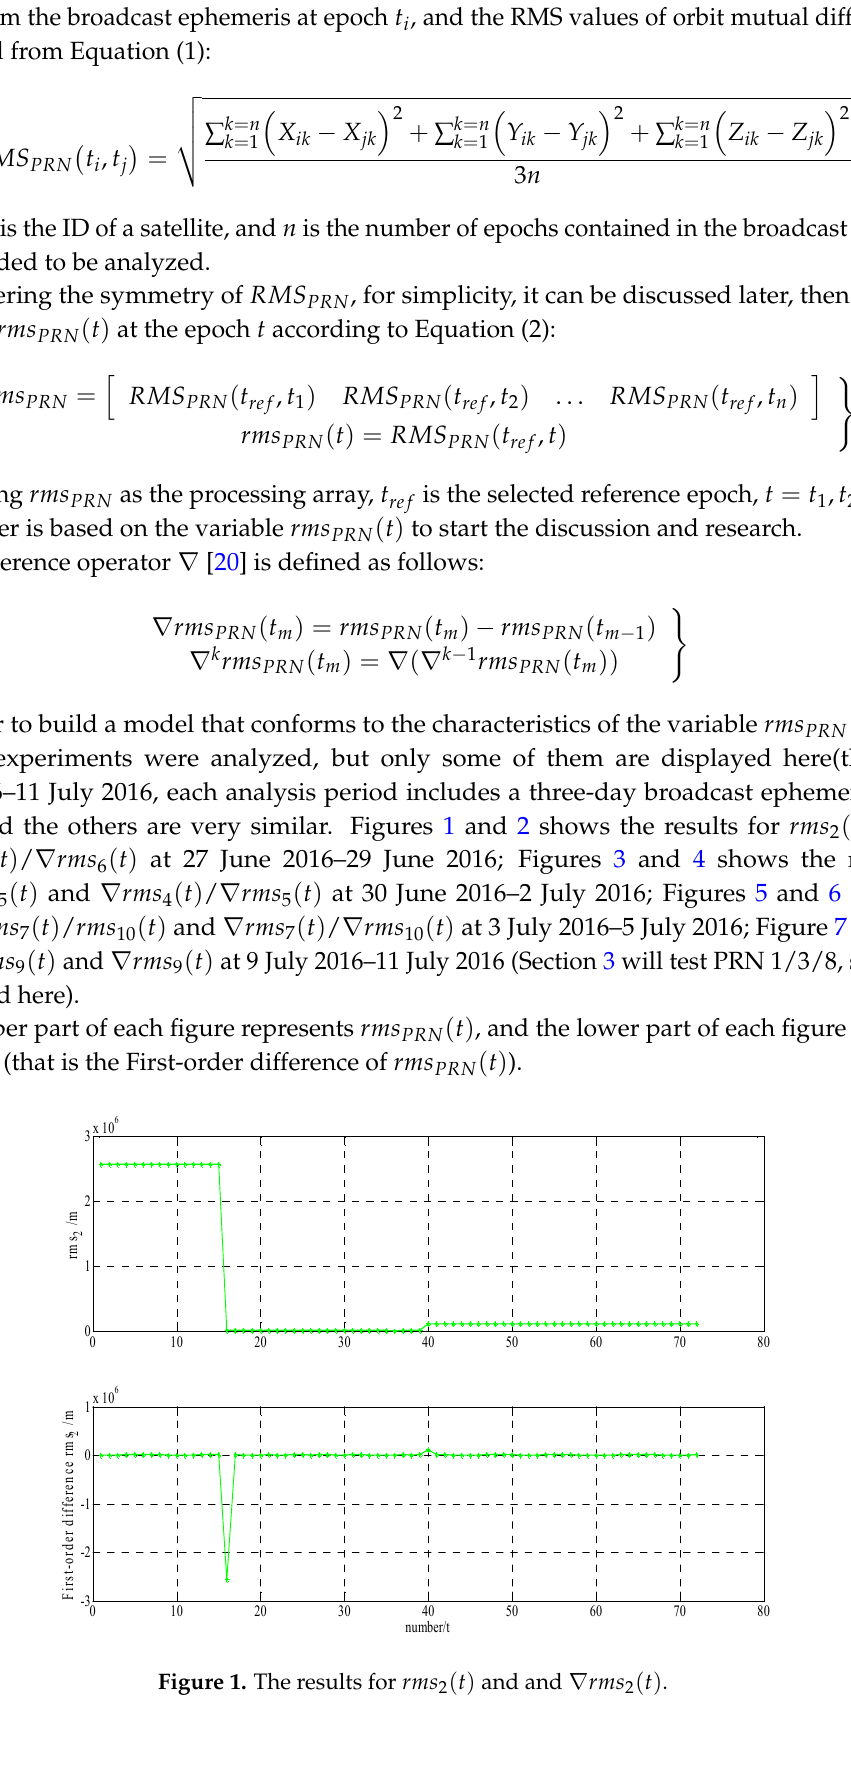
( ) rms t and ( t ) and and ∇ rms 2 2